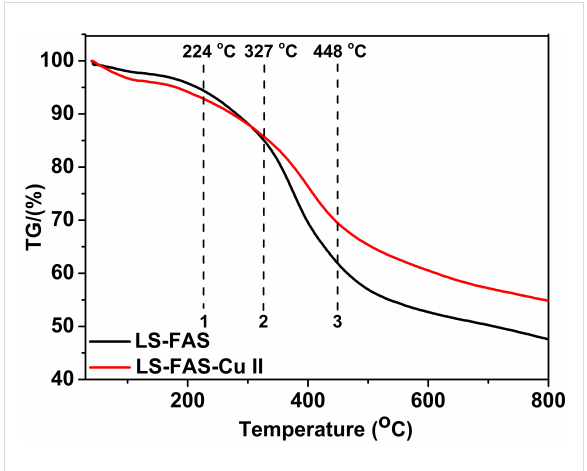
Figure 3: Thermogravimetric weight loss of the obtained materials LS-FAS and LS-FAS-Cu.